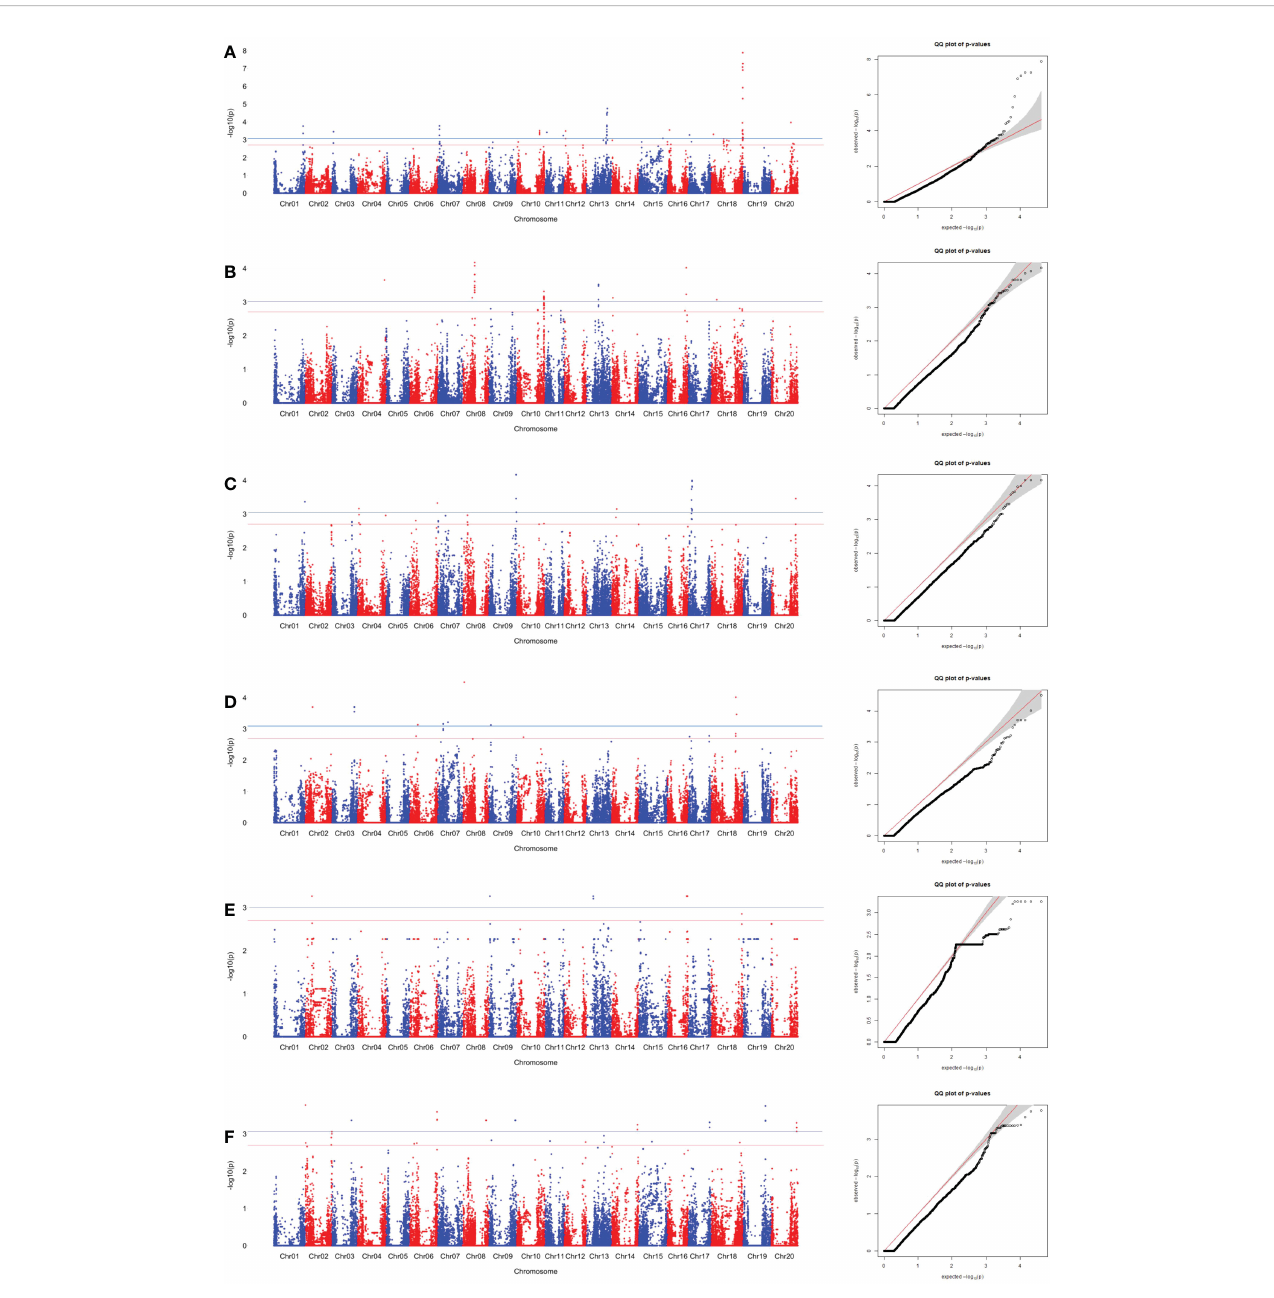
FIGURE 5 SNP associations for Ala content in edamame beans harvest from (A) Blacksburg, VA, 2018, (B) Blacksburg, VA, 2019, (C) Portageville, MO, 2018, (D) Portageville, MO, 2019, (E) Fayetteville, AR, 2018, (F) Fayetteville, AR, 2019, are displayed in Manhattan plots with chromosomes in alternating colors, signi fi cance thresholds-log10(P) > 3.01 (the blue line) and suggestive threshold-log10(P) > 2.70 (the red line). Each respective QQ plot displays observed-log10(P) against